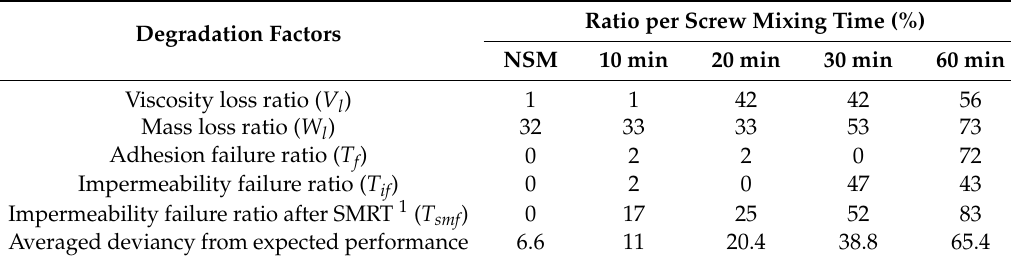
Table 11. Estimation of the deviancy from the expected performance of SPRG (7 days